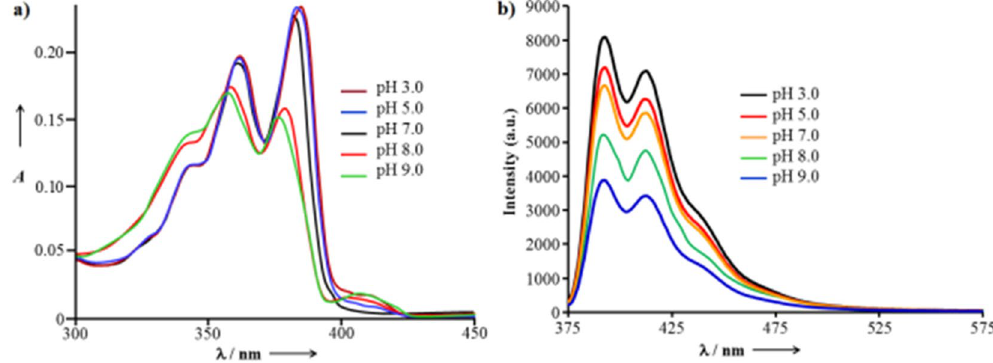
Figure 2. UV-vis absorption and emission spectra of NDI-L-Glu (1) . ( a ) The UV spectra and ( b ) fluorescence spectra ( λ